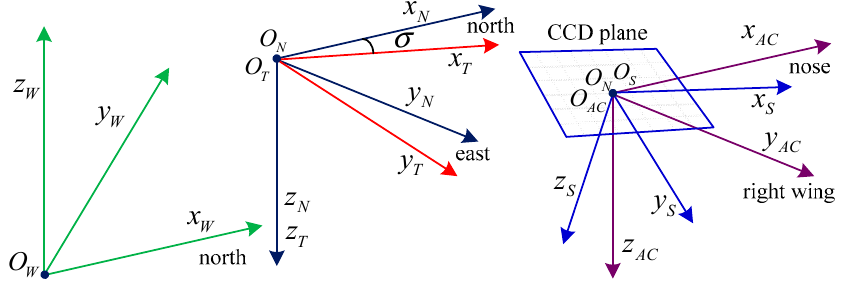
Figure 3. Fundamental coordinate frames.